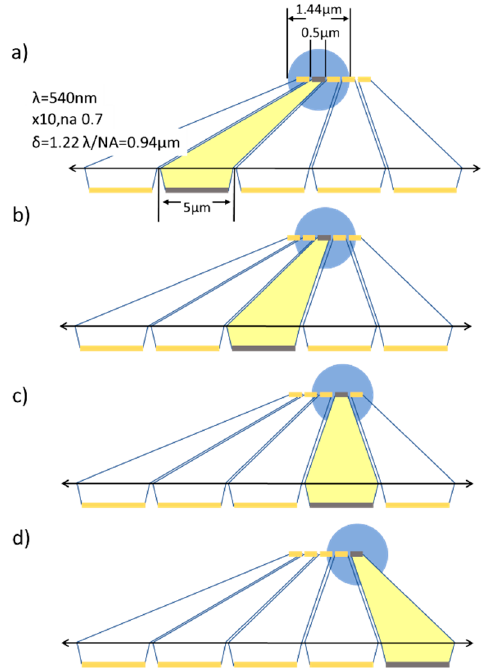
Figure 7. ( a ) Diffracted light spot (at top , in blue) produced by downscaling the second LED in the array (in yellow, at bottom ) by means of a lens in between. The third ( b ), forth ( c ) and fifth ( d ) LEDs downscaled similarly produce spots less spaced than their own dimension, generating oversampled e-STOM images.